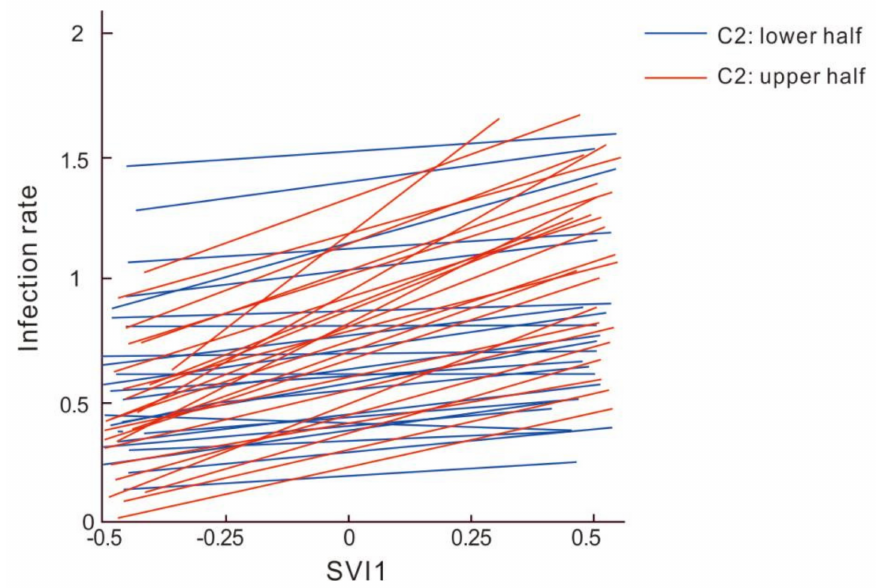
Figure 2. Effect of the state-level C2 (workplace closure index) on the regulation of the influence of the SVI1 (SES subindex) on the infection